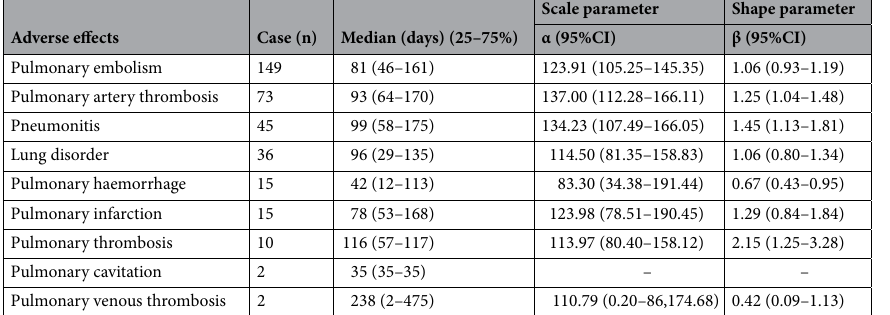
Table 3. Medians and Weibull parameters of lung toxicity. “Cases” indicate number of reported cases of pulmonary toxicity. The detected pulmonary toxicity signals were analysed to determine time to onset. 95%CI 95% confidence interval.